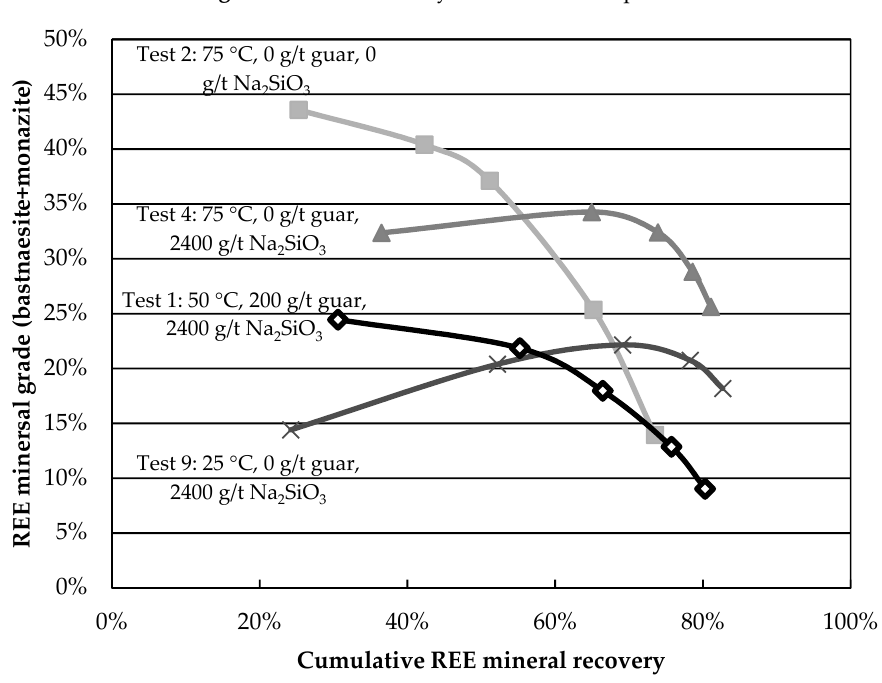
Figure 5. Grade-recovery curves for selected flotation tests.